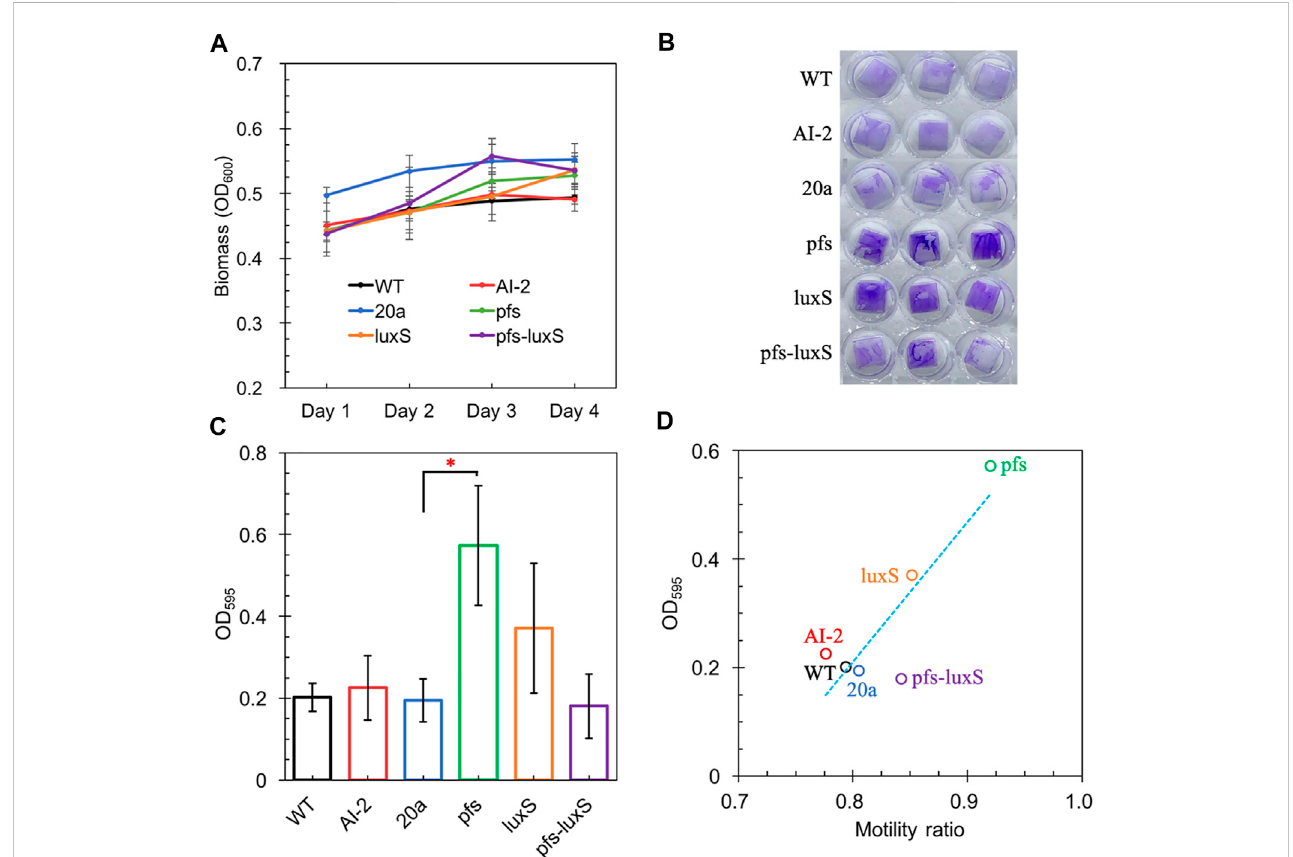
FIGURE 5 The Growth of strains on a 24-wells plate (A) ; Crystal violet staining of WT, WT (with 4.47 μ M AI-2 addition), ZM4:20a, ZM4:pfs, ZM4:luxS, and ZM4:pfs- luxS (B) ; Quanti fi cation of bio fi lm (C) ; Correlations between bio fi lm and bacterial motility (D) . Three replicates. * represents p -value < 0.1.